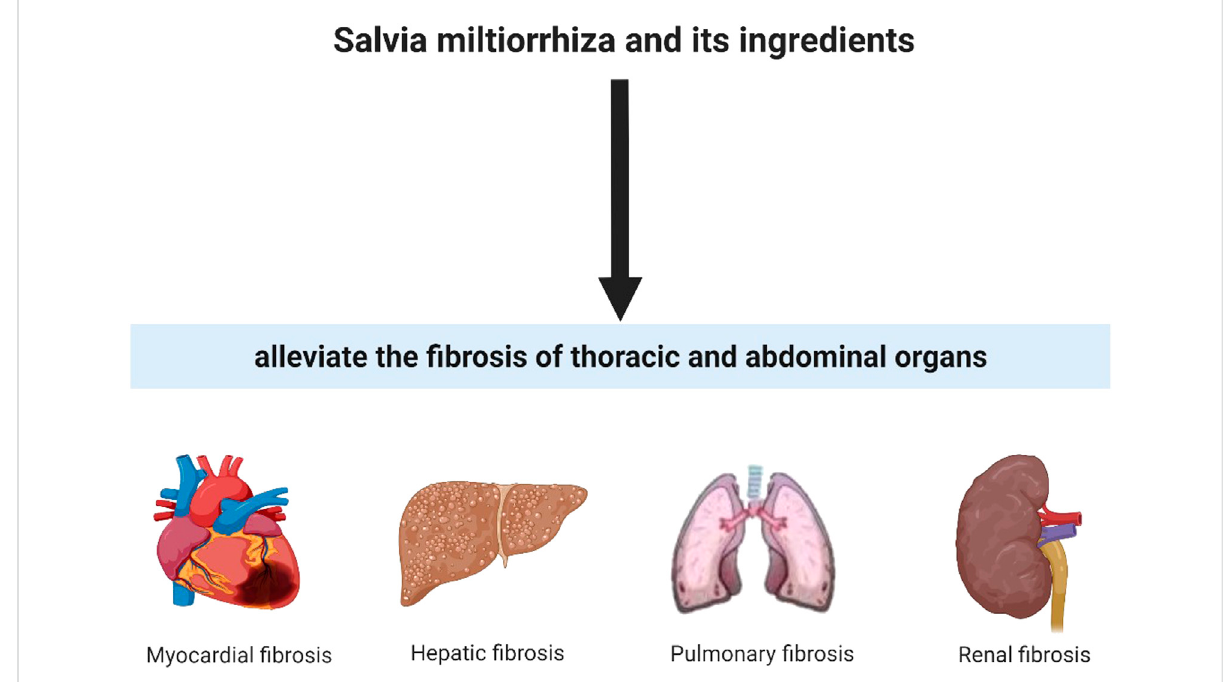
FIGURE 2 Salvia miltiorrhiza and its ingredients could alleviate fi brotic condition in thoracic and abdominal